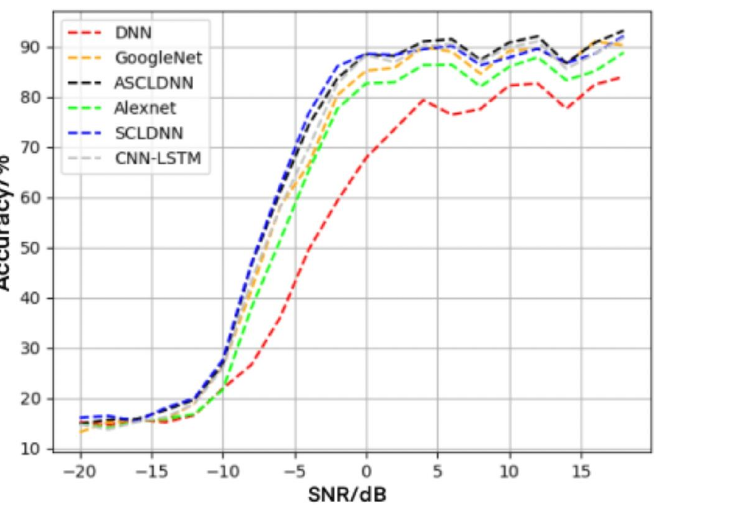
Figure 9. Comparison of recognition performance of six models